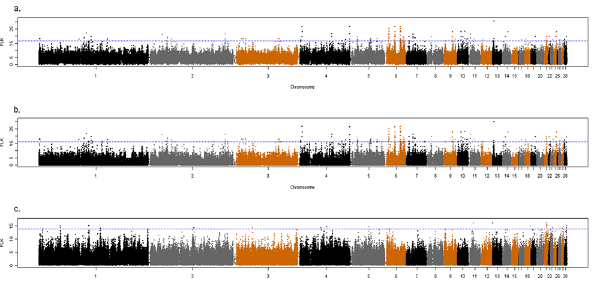
Fig 2. Manhattan plot of FLK analysis over the entire genome. Blue line indicates the upper 0.05% of FLK distribution, for (A) within all breeds, (B) within white breeds, and, (C) within brown breeds. doi:10.1371/journal.pone.0130497.g002 available in Table 2. We also detected several QTL overlapping selection signatures for traits such as breast muscle weight, abdominal fat weight and liver weight, which all are related to the breeding goals of chickens (Table 3).